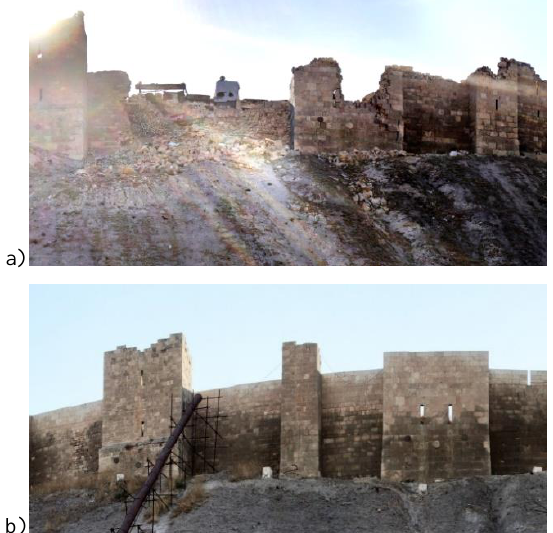
Figure 4: Citadel walls, current situation (a) and how it was in 2010 (b).